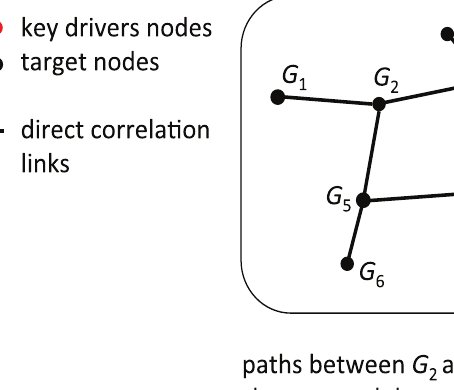
and group of genes 2